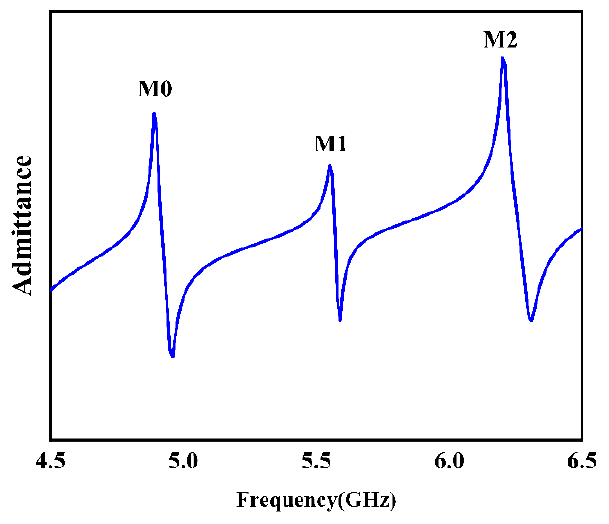
Figure 5. Admittance curves of sandwiched structure.